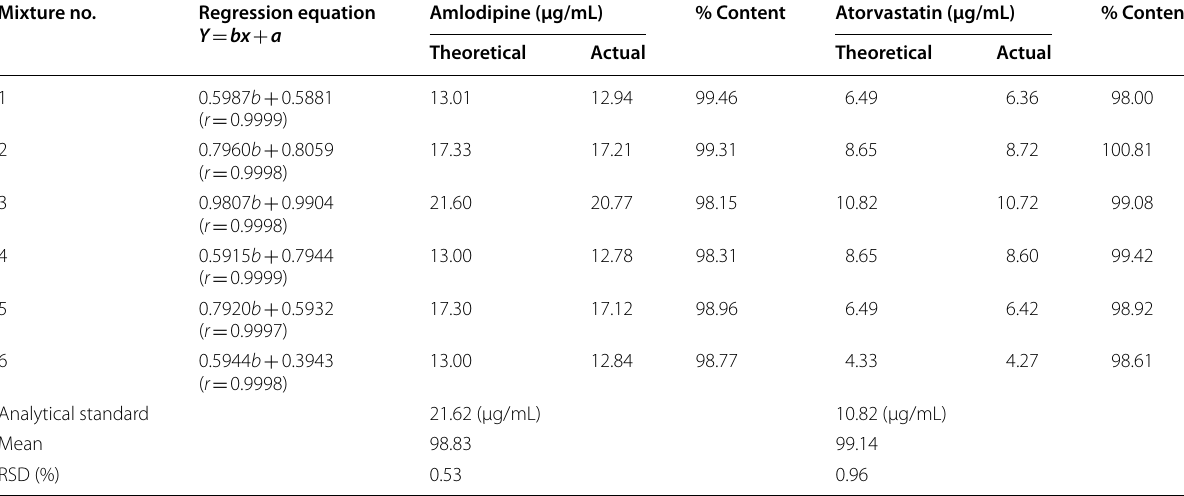
Table 5 Multiwavelength regression method recovery results Mixture no.